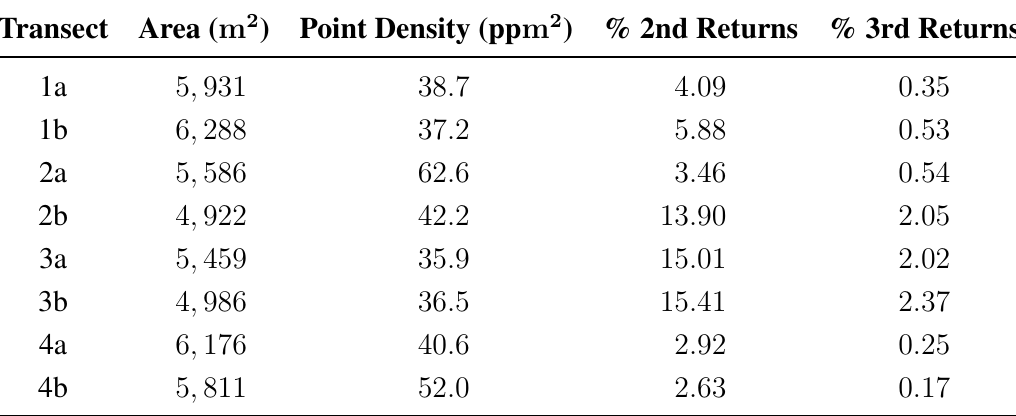
Table 3. Properties of the eight generated point